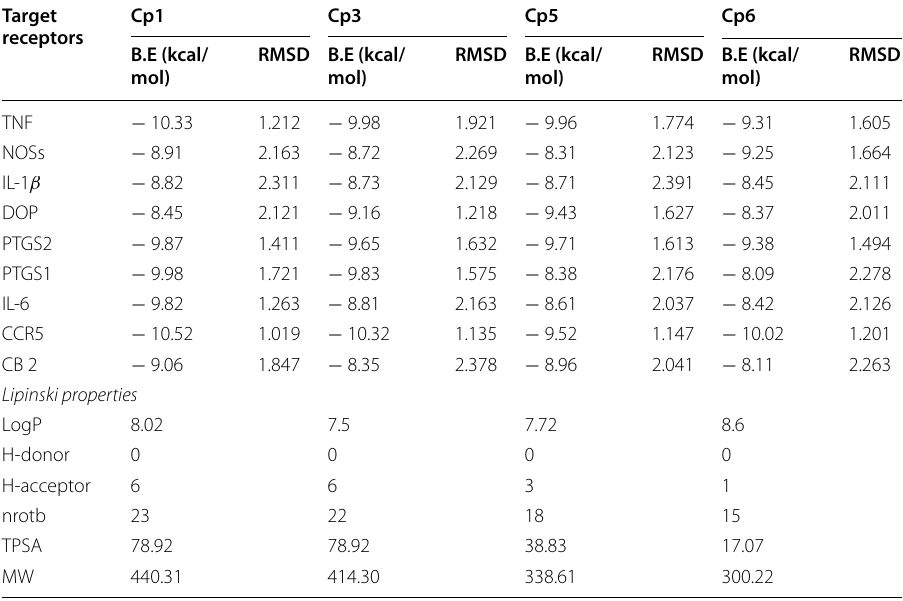
Cp1: Glyceryl diacetate-2-Oleate; Cp3: hexadecanoic acid, 2,3-bis(acetyloxy)propyl ester; Cp5: glycidyl oleate; Cp6: oleoyl chloride; logP: molecular lipophilicity potential; nrotb: number of rotatable bond; TPSA: topological polar surface area; MW: molecular